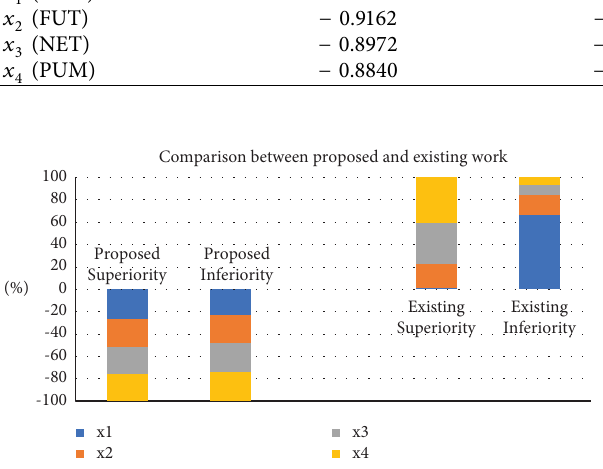
Figure 2: Comparison between proposed and existing